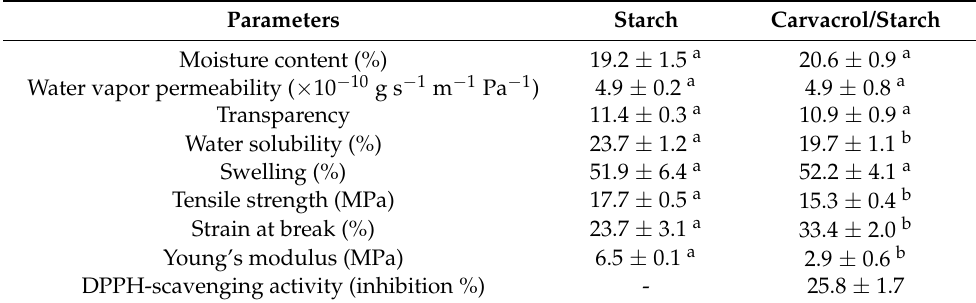
Table 1. Properties of starch and carvacrol/starch edible